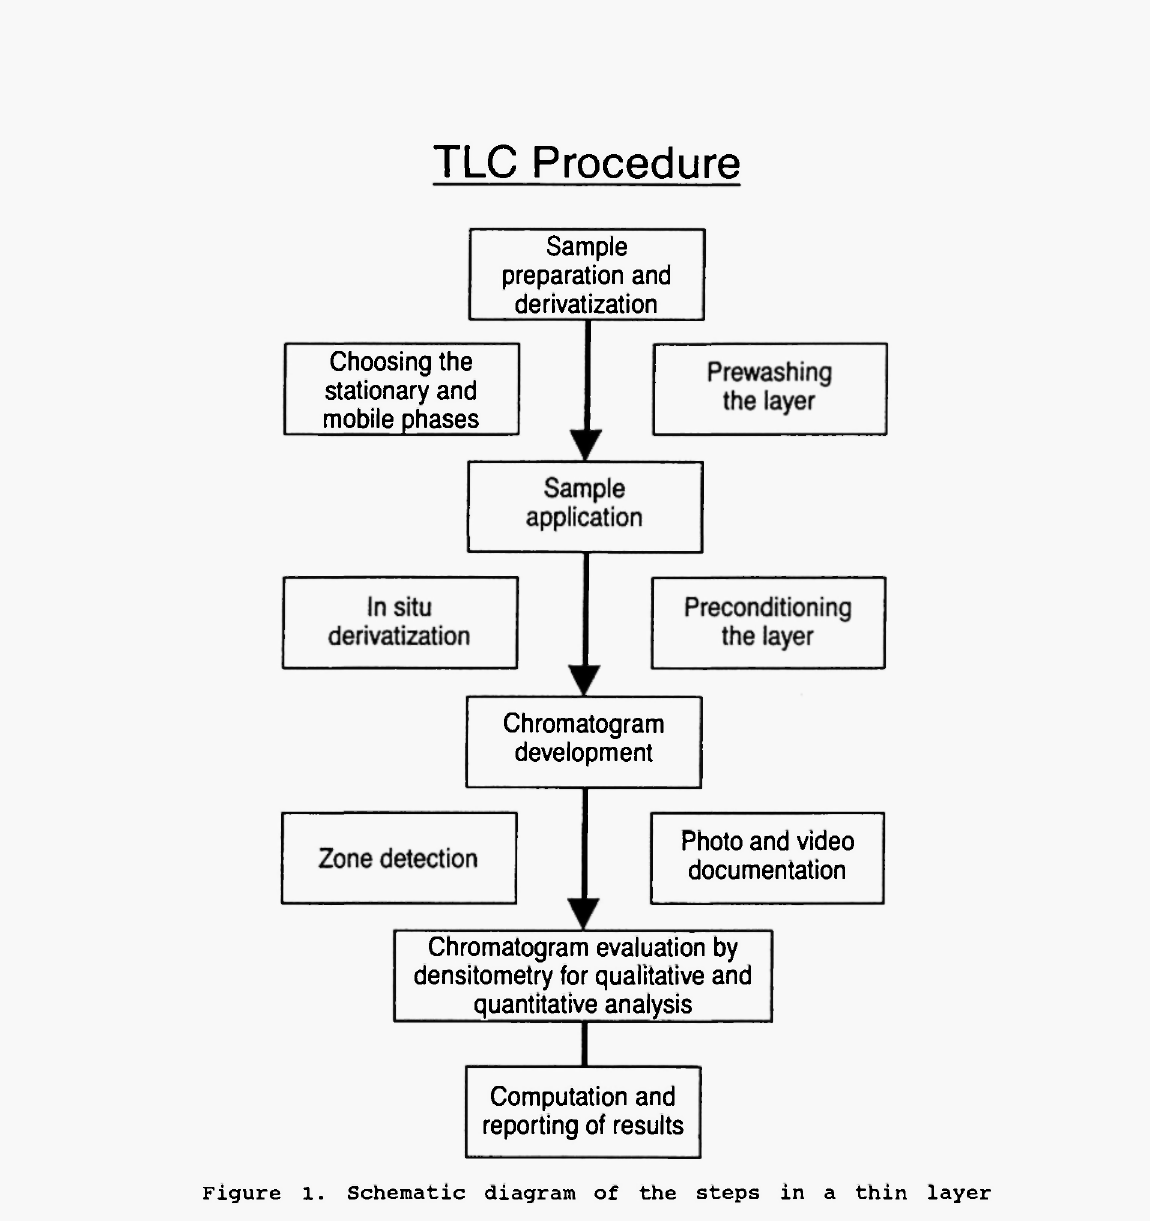
Figure 1. Schematic diagram of the steps in a thin layer chromatography analysis. (Adapted from a figure supplied by Camag Scientific